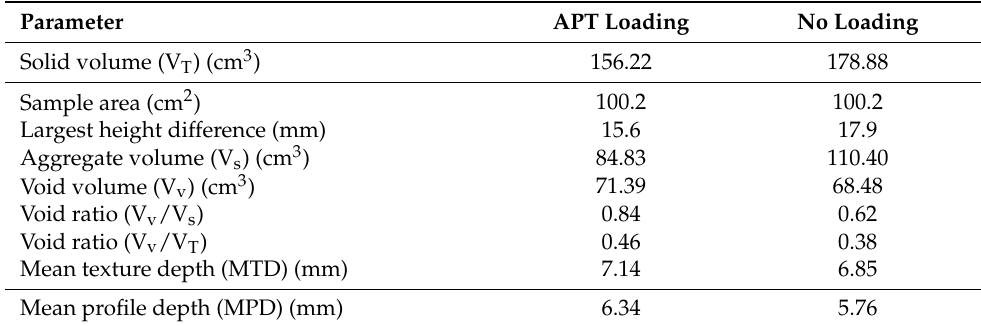
Figure 9. A 3D scan of the 20 mm single seal. Left: APT loading. Right: no loading. Table 2. Volume and void ratios calculated from a statistical analysis of the 3D scans of the single 20 mm seal shown in Figure 9.